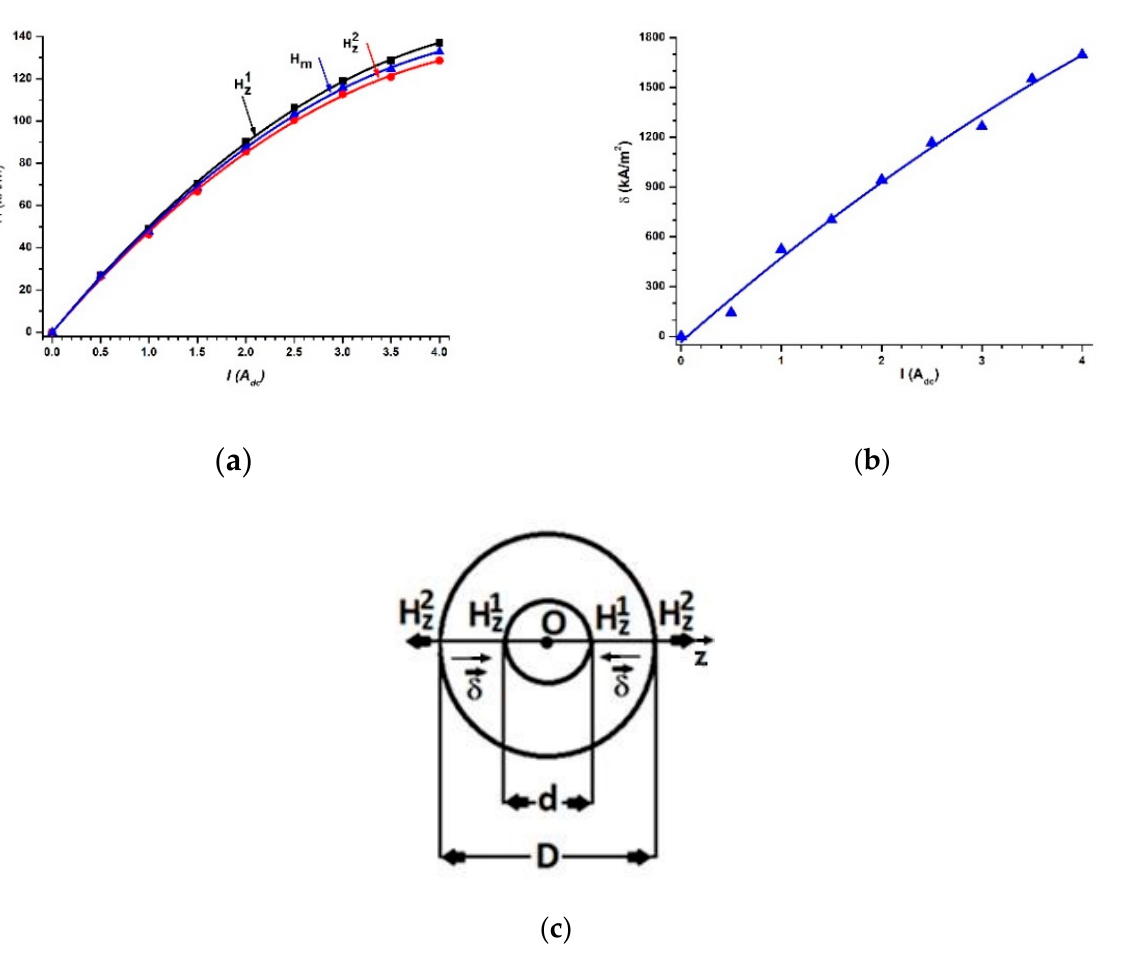
Figure 7. ( a ) The magnetic field intensities H 1 z , H 2 z and H m as functions of the electric current intensity, I; ( b ) dependence of the magnetic field intensity gradient, δ , on the electric current intensity, I; ( c ) cross-section of CCs, where D is the external diameter and d is the internal diameter.